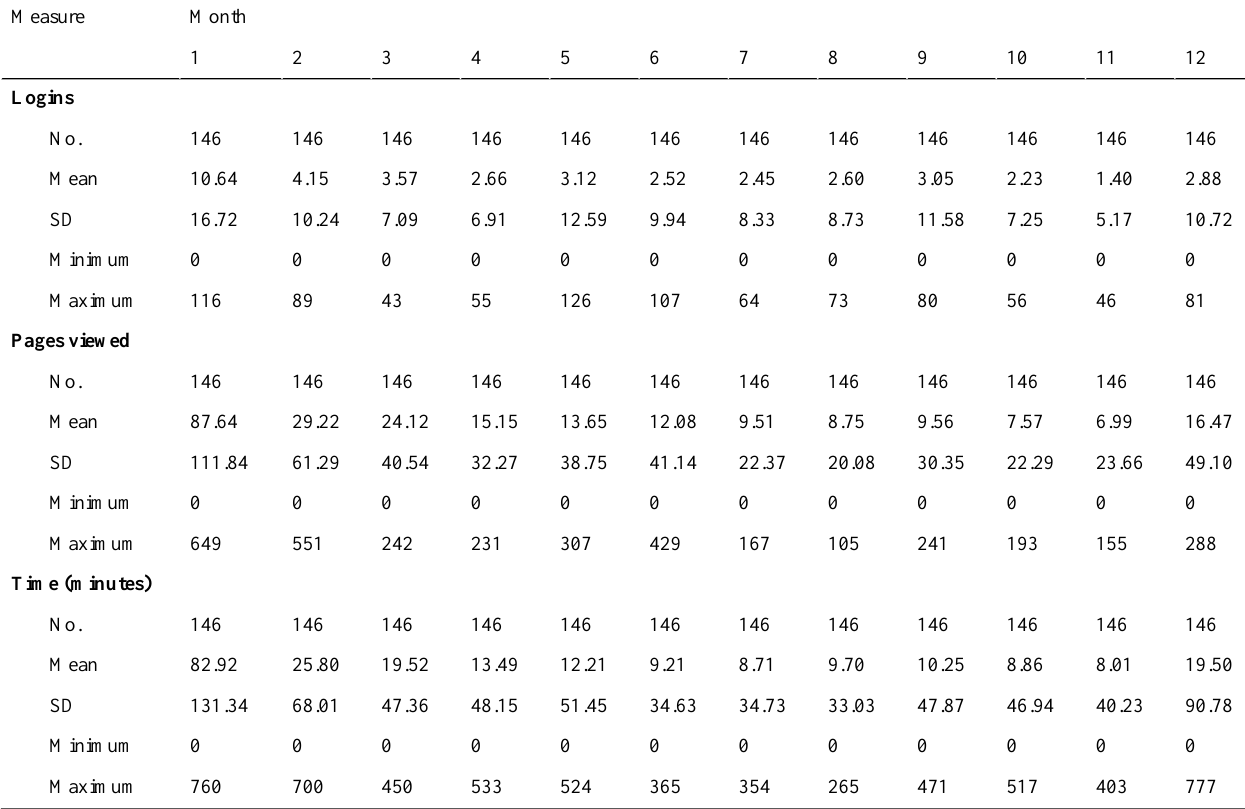
Table 4. Logins, pages viewed, and time spent for the 146 potential